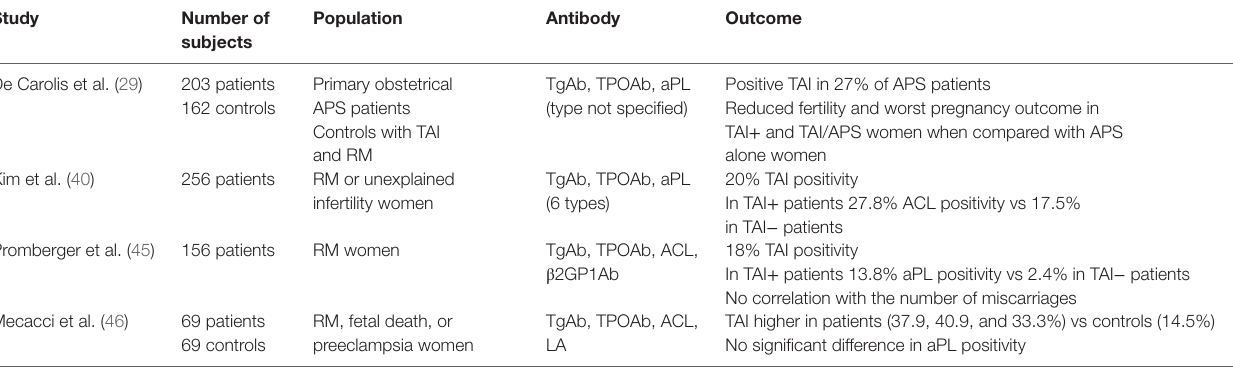
TAble 2 | APS, TAI, and pregnancy.